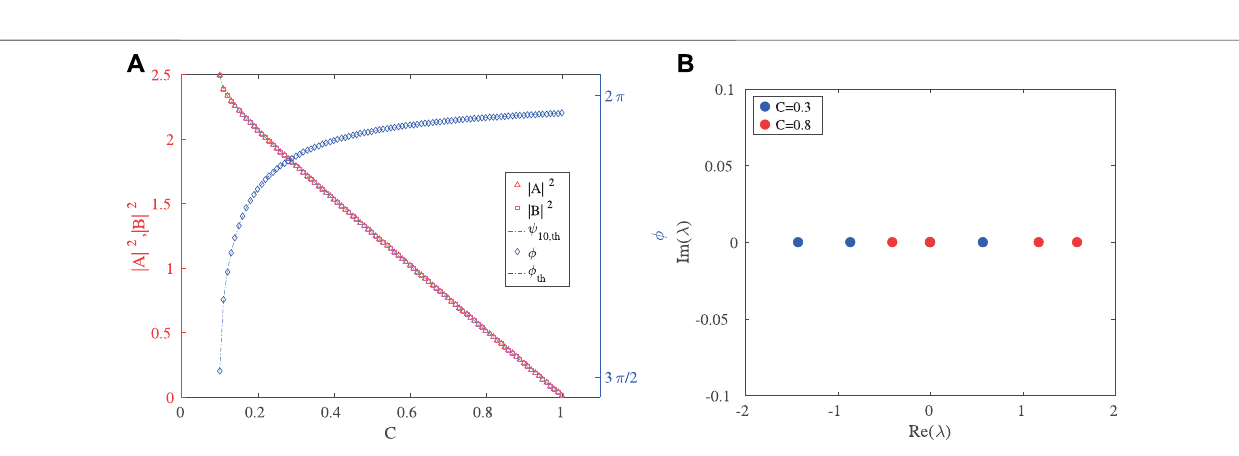
FIGURE 3 | (A) Amplitude and phase of steady state symmetric solutions from the lower branch. (B) Spectral plane representation of eigenvalues for C = 0.3 and C = 0.8. The other parameter values are the same as in Figure 1 .